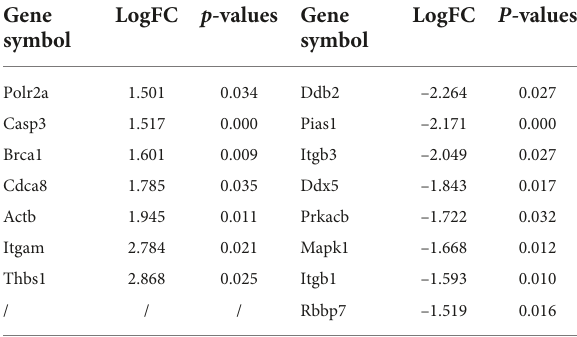
TABLE 4 The hub-genes of